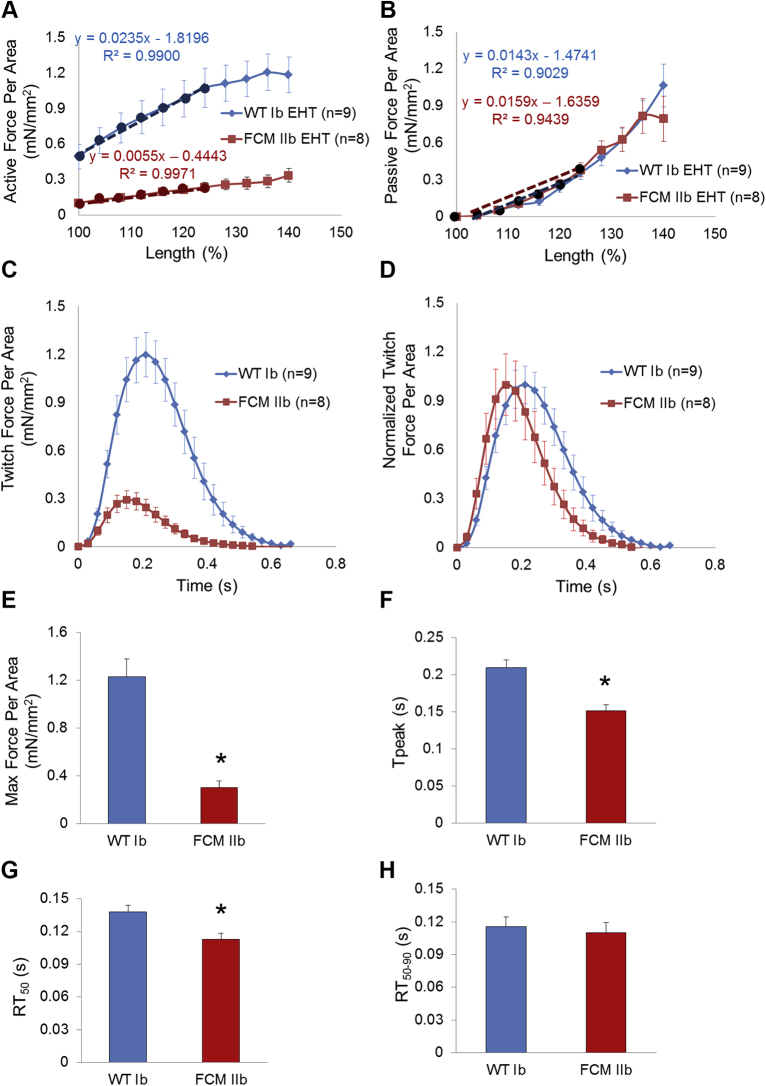
Force-Length Curve and Maximal Twitch Force Production in Patient-Specific EHTsWT Ib-CM and FCM IIb-CM were used to generate patient-specific EHTs. After attaching EHTs to the force transducer, (A) active force per area twitch height was graphed against EHT length (Starling curve). The active force per area increased in a linear fashion over increasing preparation lengths. The slope of the first 25% length change (dotted line) was lower in the FCM EHT compared with the WT EHT (p < 0.0001), indicating impaired contractility in the FCM EHT. (B) Passive force per area was graphed against EHT length. The slope of the first 25% length change (dotted line, Young’s modulus) was unchanged between the 2 groups (p = 0.57). (C) Absolute and (D) normalized twitch force per area traces of WT Ib EHT and FCM IIb EHT measured at 140% length. (E) Maximum (Max) force per area produced. (F) Time to peak contraction (Tpeak). (G) Tpeak to 50% relaxation (RT50). (H) Time from 50% to 90% relaxation (RT50–90). All EHTs were paced at 1.5 Hz, and all force values were normalized to cross-sectional area. *p < 0.05 (Student’s t-test). Error bars indicate SEM. Abbreviations as in Figures 1 and 3.